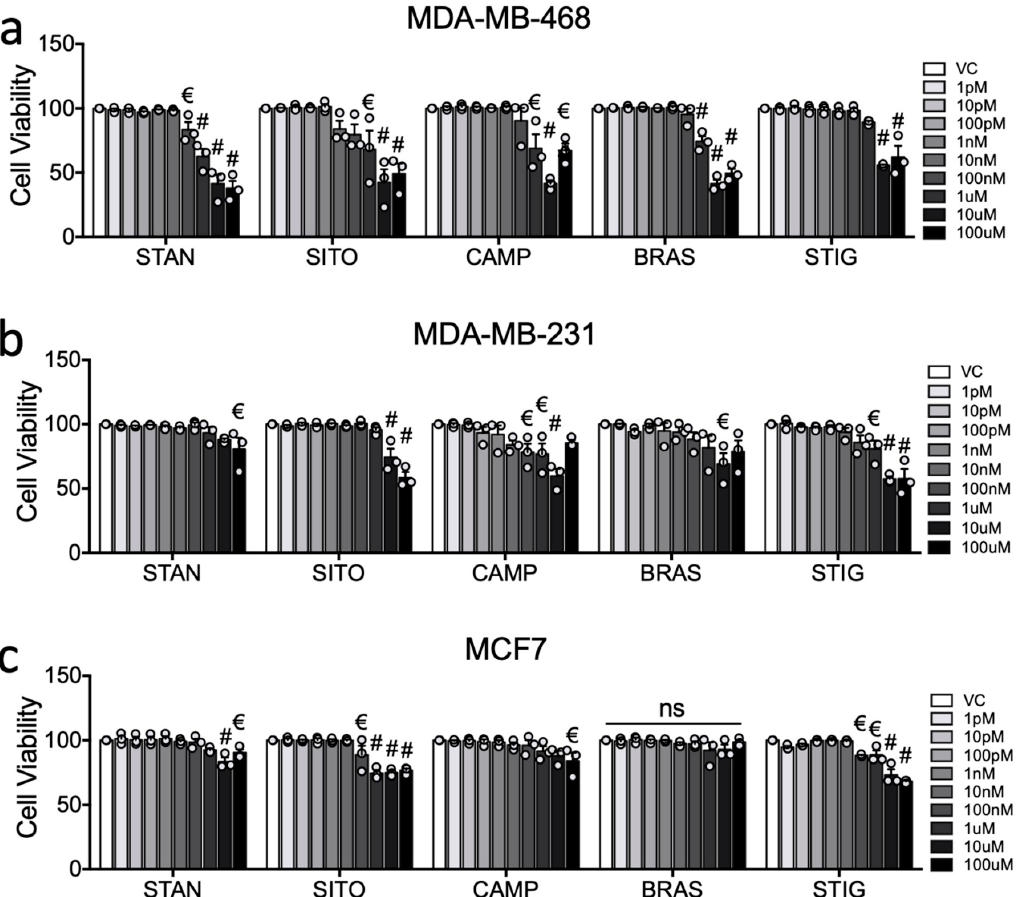
Figure 2. Phytosterols are anti-proliferative in breast cancer cell cultures. The anti-proliferative effects of STIG, SITO, CAMP, BRASS and STIG over 48 h was assessed by MTT in ( a ) MDA-MB-468, ( b ) MDA-MB-231, and ( c ) MCF7 cells. Cell viability relative to vehicle control was measured after treating with plant sterols and stanols (PSSs) at indicated concentrations. Data are presented as mean of three independent replicates (open circles) with SEM. For assessing changes between individual concentrations and vehicle, one-way ANOVA with Holm-Sidak correction for multiple testing and post-test for linear trend was performed. Significance levels are indicated by € = p < 0.05 and # = p < 0.0001. Linear trend was significant for all PSS in all cell lines except for BRAS in MCF7 (ns).